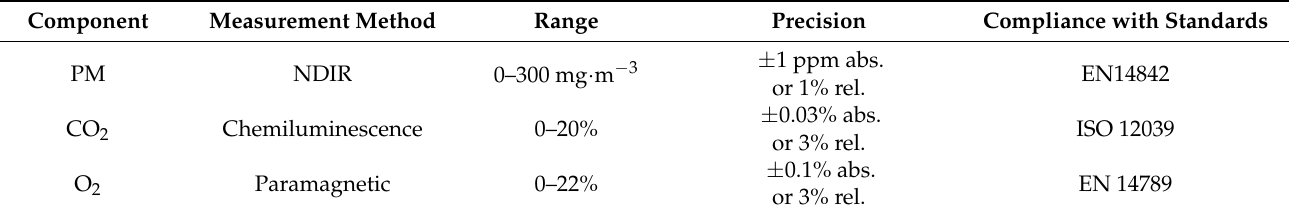
Table 7. Technical data of the Testo 380 particulate matter